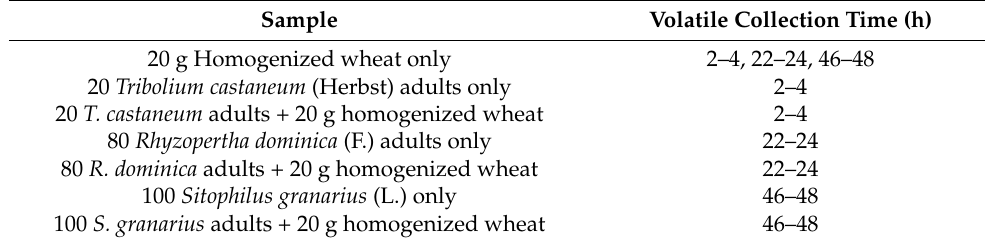
Table 1. The seven treatments used in GC, GC/MS analysis.